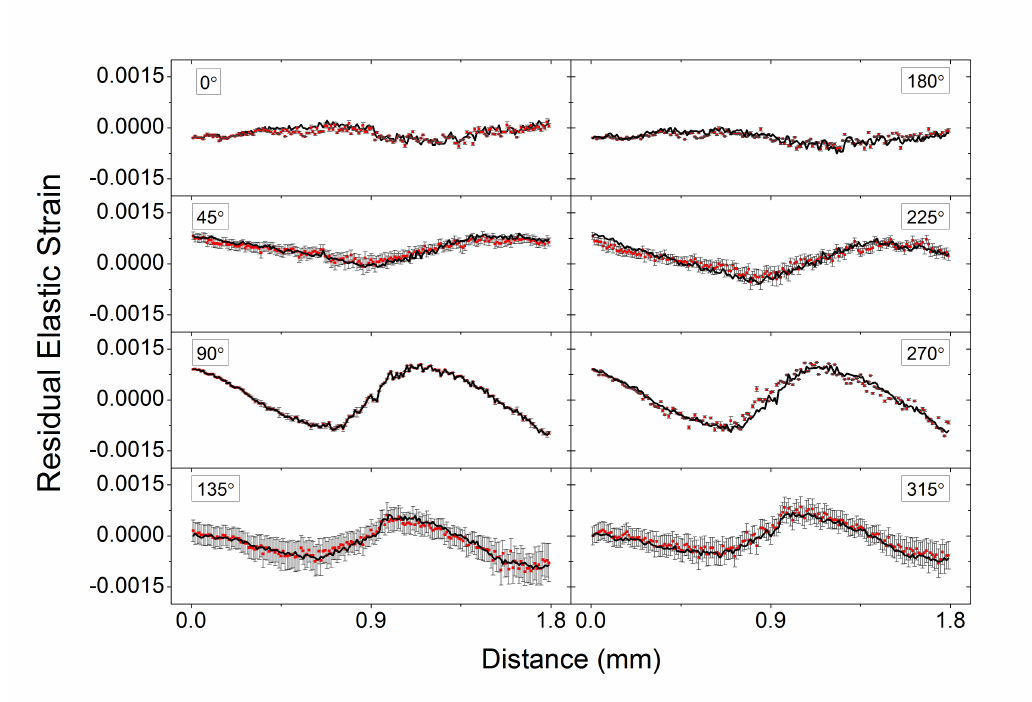
Figure 4. Comparison of residual elastic strains obtained from XRD-DIC (red dots with error bar) and ConFit method (solid black curve) at the azimuthal angles of 0 ◦ , 45 ◦ , 90 ◦ , 135 ◦ , 180 ◦ , 225 ◦ , 270 ◦ and 315 ◦